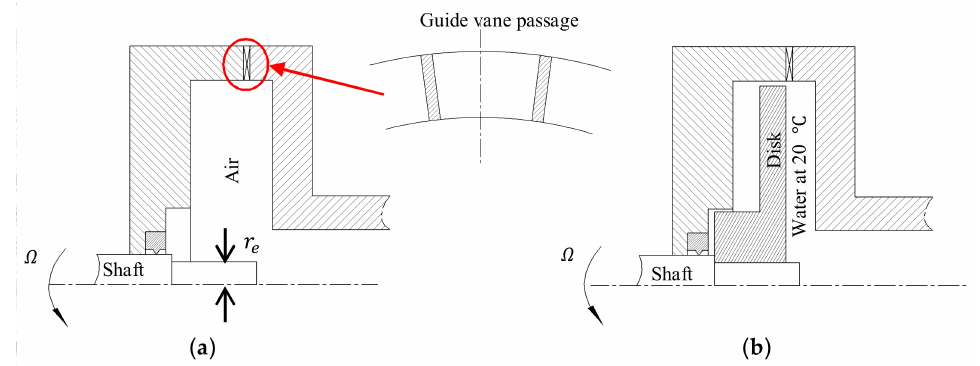
Figure 7. Cavities to measure the axial thrust: ( a ) Step 1 and ( b ) Step 2. r e : radius of the shaft end; Ω : angular velocity of the disk.